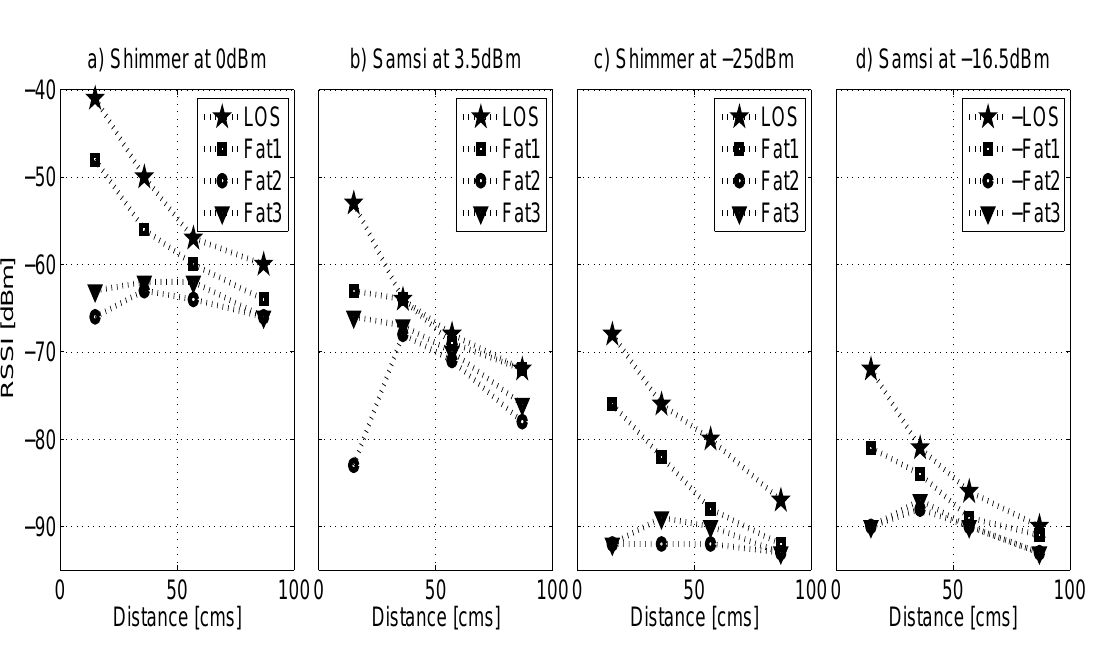
Figure 5. Homogeneous and layered biological tissue: fat